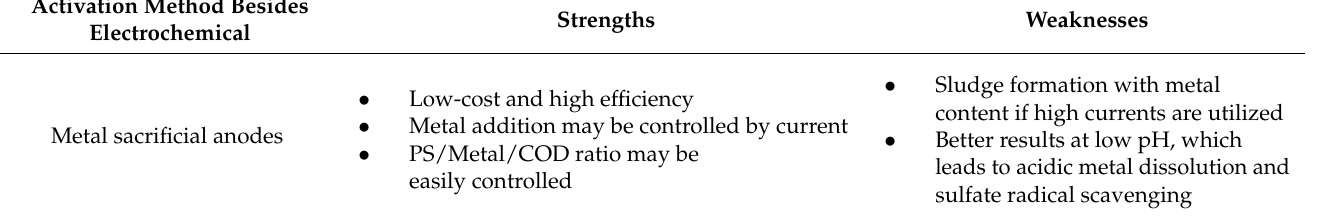
Table 6. Strengths and weaknesses of the hybrid persulfate electro-activation process. Activation Method Besides Strengths